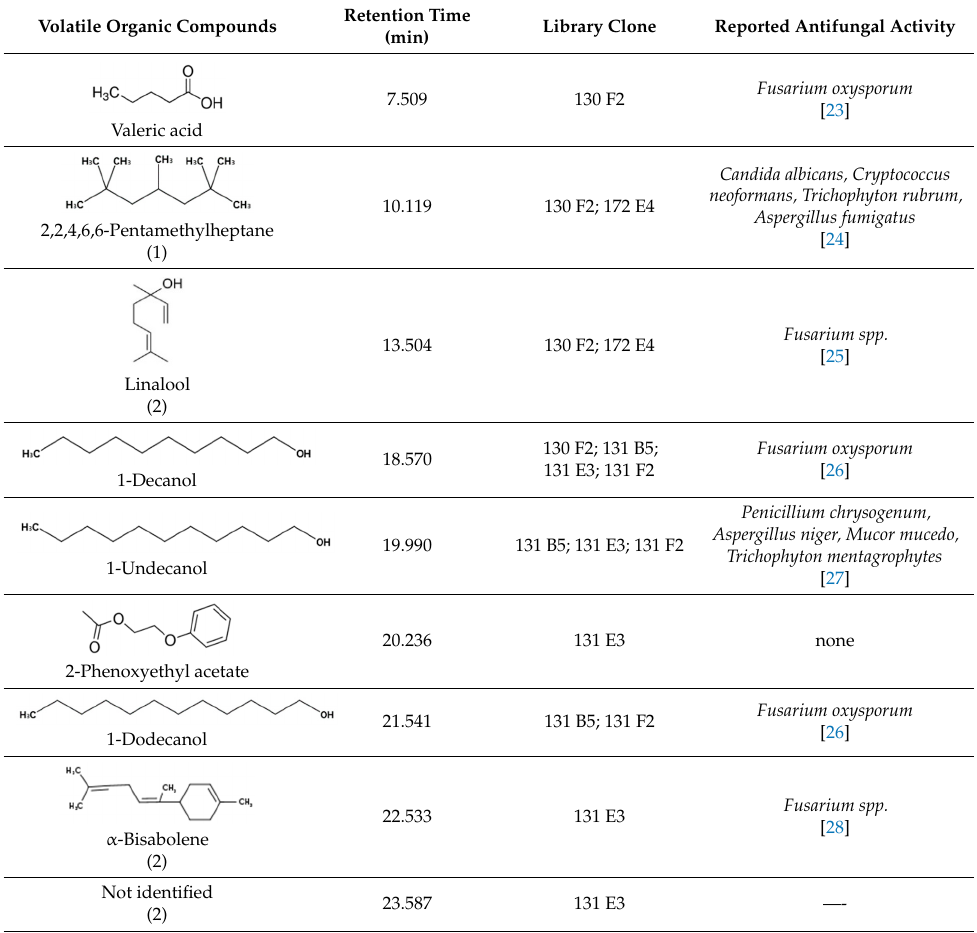
times, the producing library clone and previously reported antifungal activity. VOCs, which were detected as interaction compounds upon co-cultivation of the clones with the fungus in a single vial (1) or in separate vials (2) are marked.